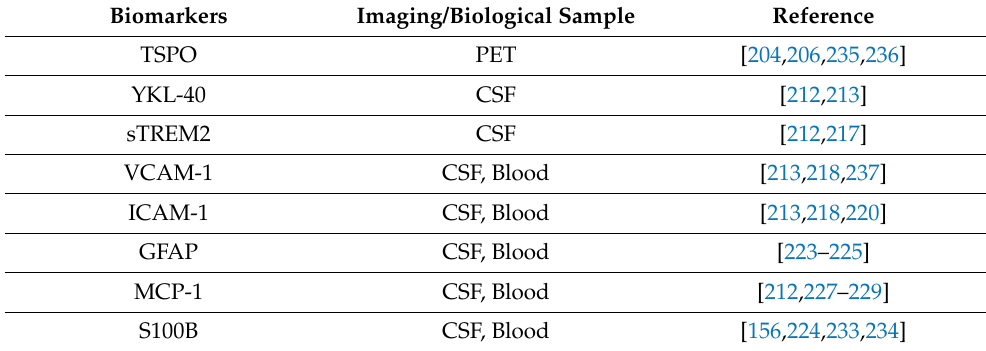
Table 1. An overview of biomarkers with increased expression due to AD-related